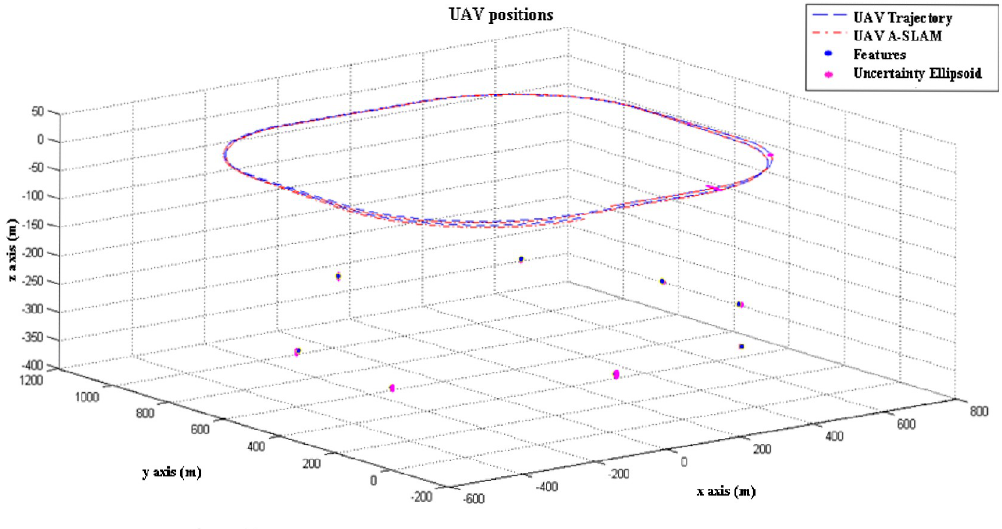
Fig 6. Simulation flight